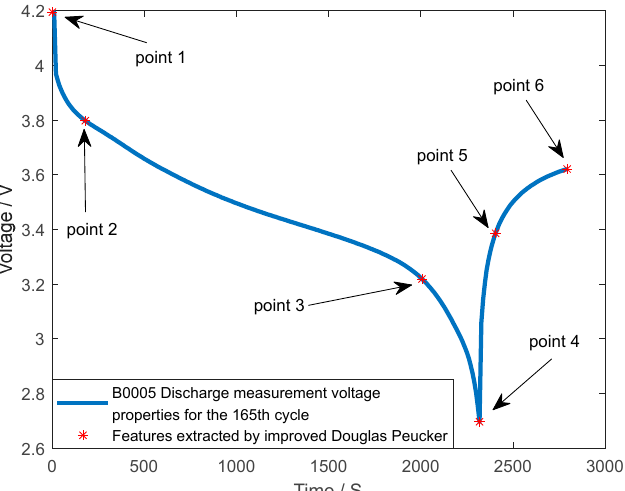
Figure 6. Measurement voltage properties of discharge at points extracted by the Improved Douglas–Peucker algorithm.